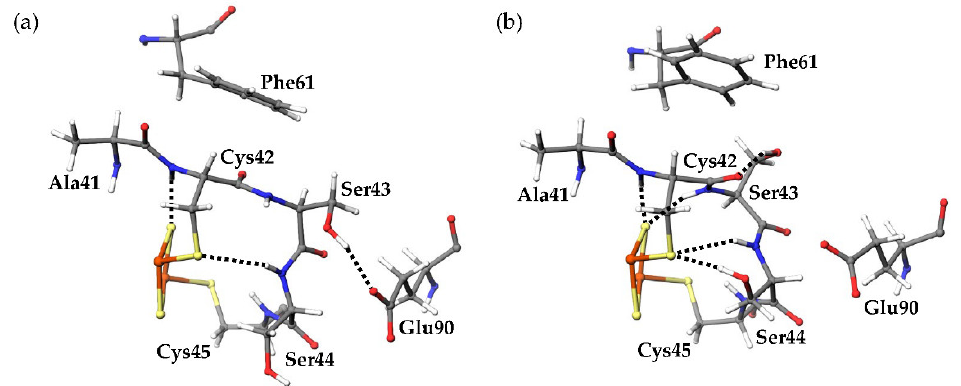
Figure 5. Structural differences around the active site between ( a ) oxidized and ( b ) reduced forms. The hydrogen bonds are presented as dotted lines. The hydrogens, carbons, nitrogens, oxygens, sulfurs, and irons are displayed in white, gray, red, yellow, and orange, respectively, in a ball-and- stick model.